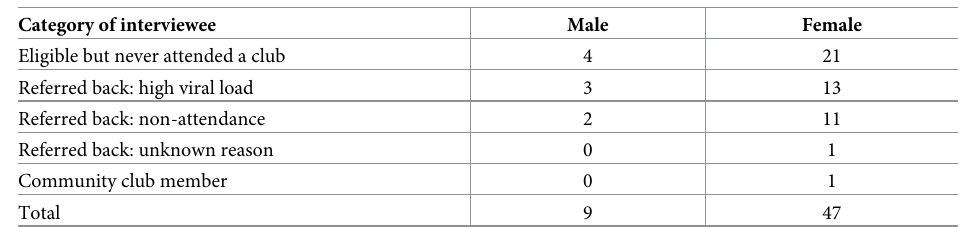
Table 2. In-depth interview